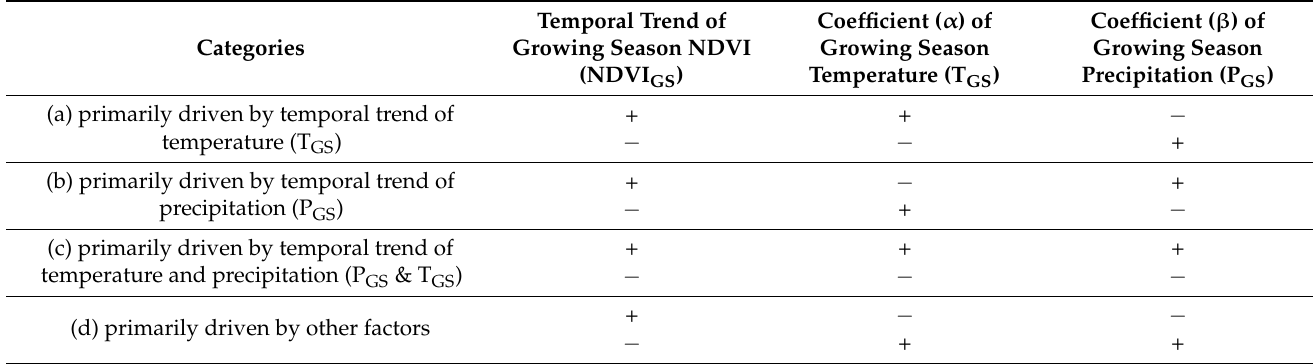
Table 1. Pixels belonging to four different driving factors